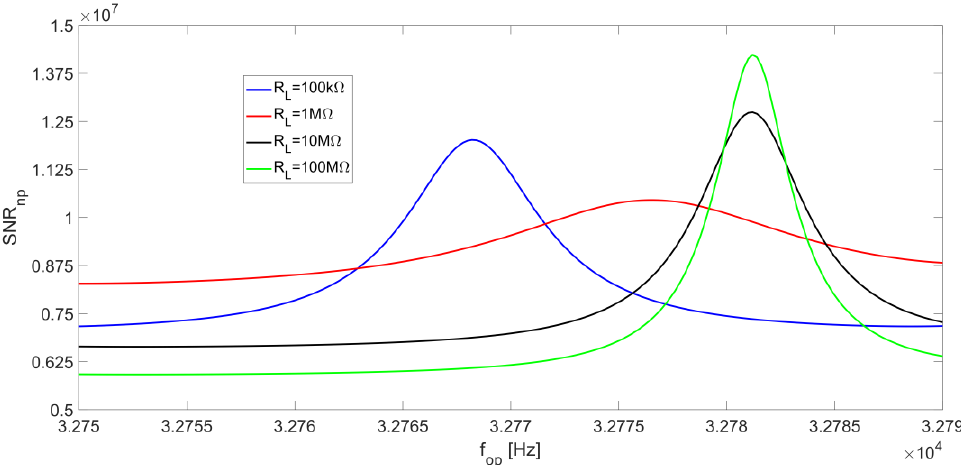
Figure 17. R P noise contribution to the SNR n at the LIA output as a function of the operating frequency, for different values of R L and at a low-pass filter bandwidth of BW = 5 Hz.